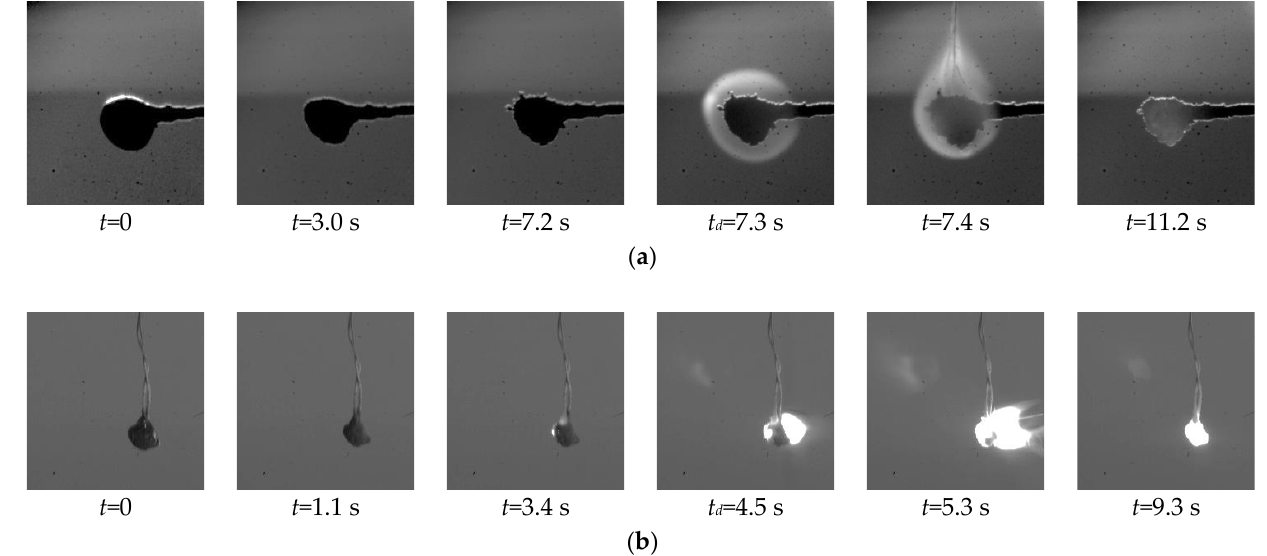
Figure 2. Video frames of ignition and combustion of CLF droplets No. 5 (FC 90% + cardboard 10%) at T g = 873 K [23] under the following conditions: ( a ) radiant heating ( V g ≈ 0); ( b ) convective heating ( V g ≈ 3 m/s).